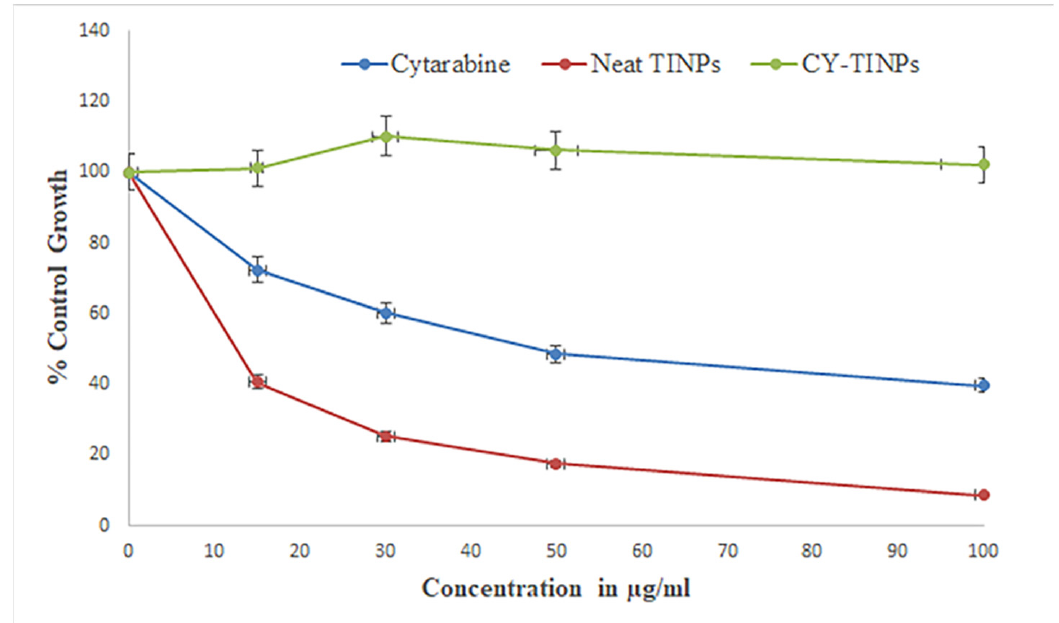
Figure 10. Anticancer activity graph of cytarabine, neat TINPs, and cytarabine ‐ loaded TINPs (CY ‐ TINPs).